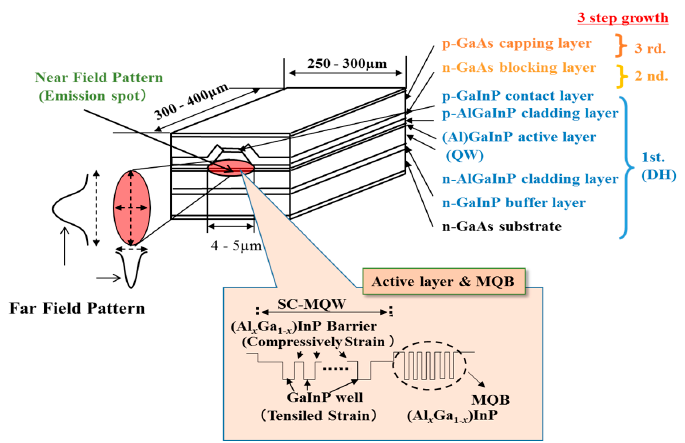
Figure 9. The 630-nm band AlGaInP laser diode, adapted from [65], with copyright permission from © 1992 IEEE.